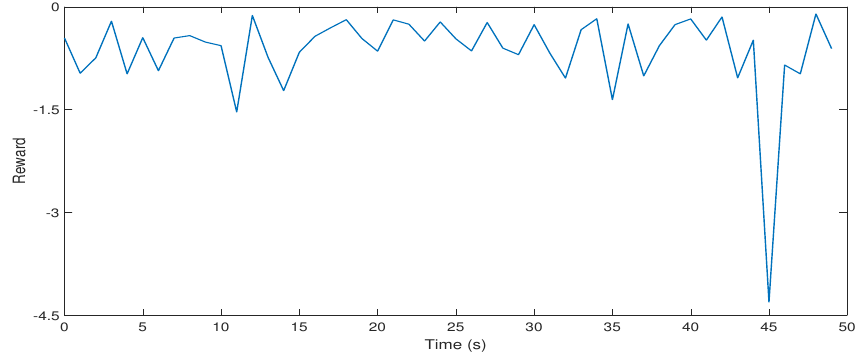
Figure 21. Time series reward under